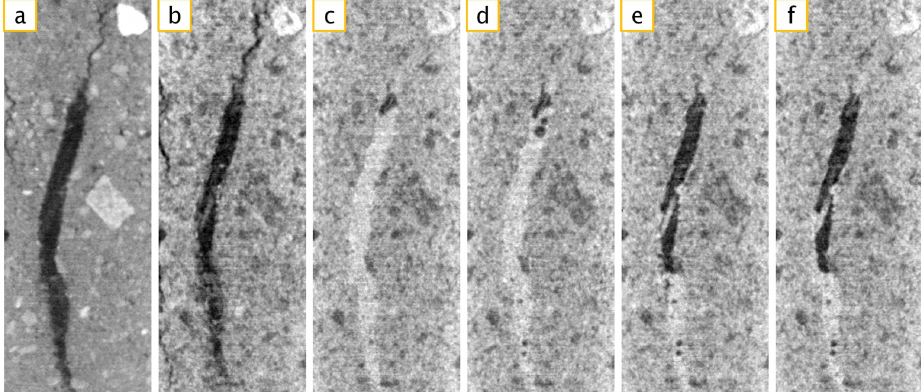
Figure 9. Cropped part (22.1 × 60.0mm 2 ) of the vertical cross sections through the 3-D X-ray (a) and neutron data sets (b–c) of the intact soil sample taken into a cylinder (a diameter of 34mm, height of 87mm) during various stages of the recurrent ponded infiltration experiment: (a) and (b) before experiment when the macropore in the center of the image is filled with air, (c) during the infiltration when the macropore is entirely filled with water, (d) during continuing infiltration (e) after draining the sample, and (f) during second infiltration episode when the entrapped air formed in the